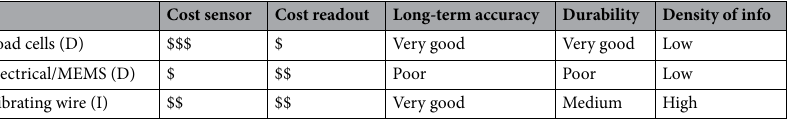
Table 3. Summary table for the validation of different tested technologies based on Tajo viaduct